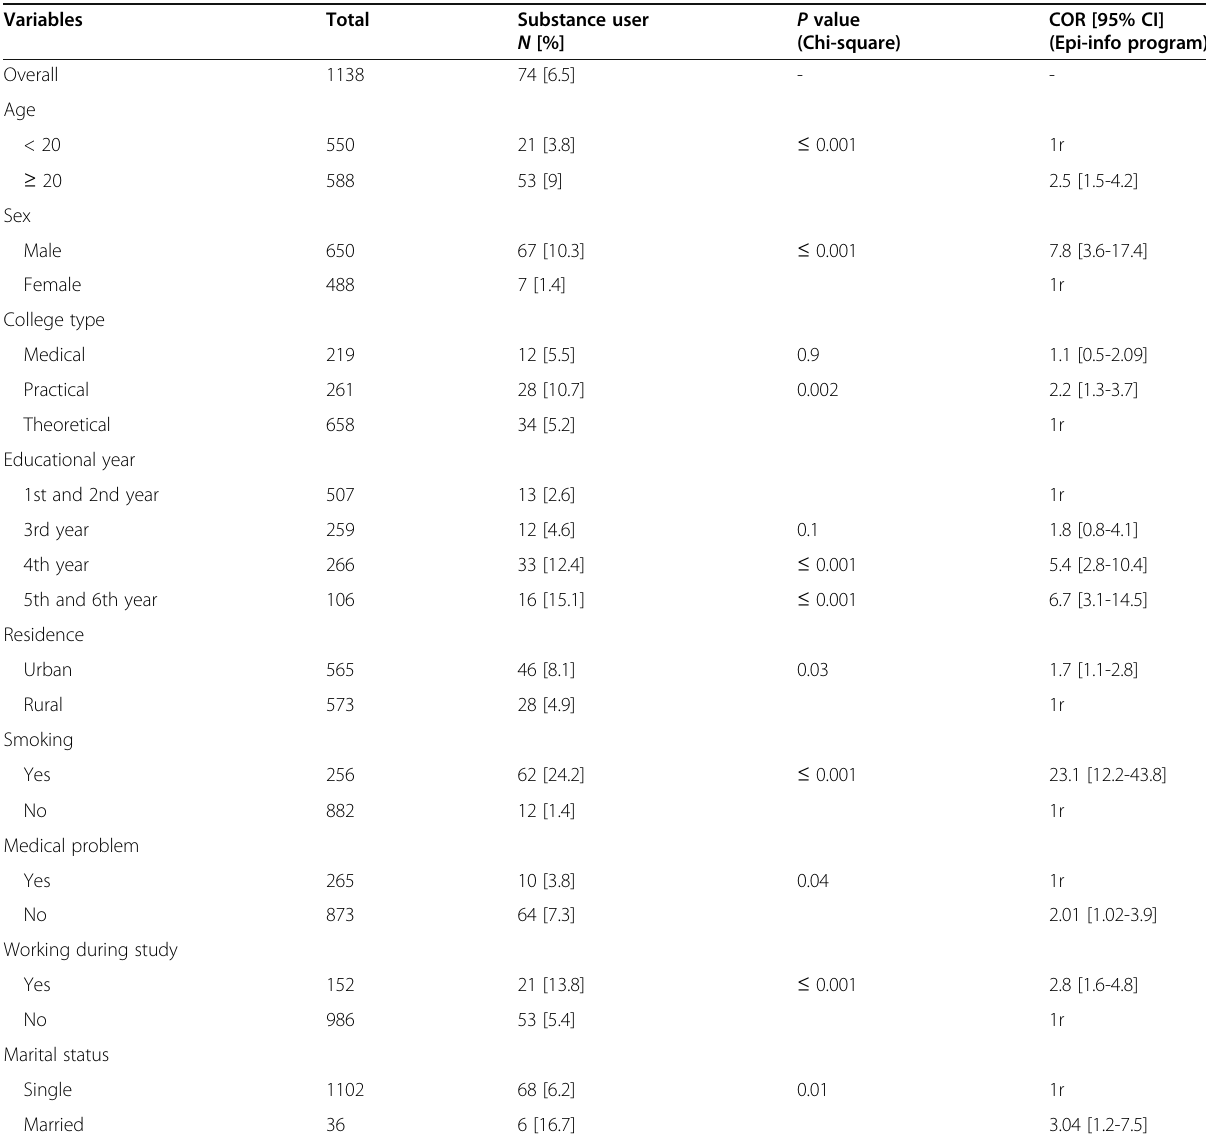
Table 4 Bivariate analysis of factors associated with substance use